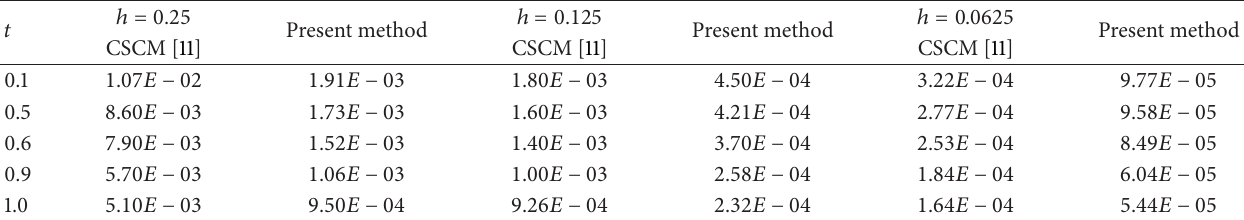
Table 5: Absolute errors of numerical value of 𝑢 for Example 2 with different space step size, 𝑘 = 0.0001 , at selected time levels and compare with CSCM